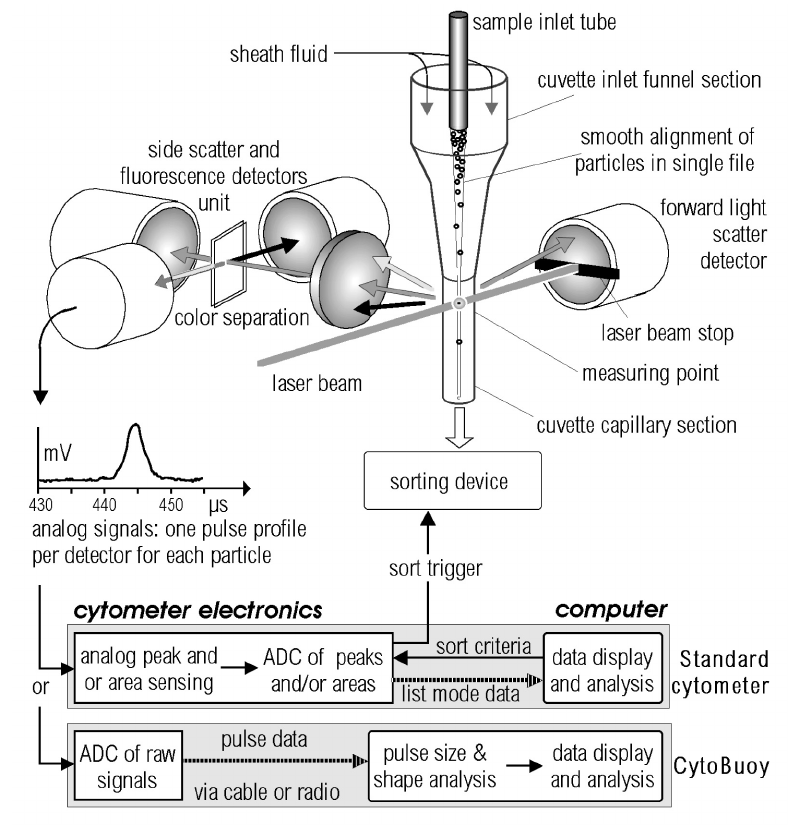
F IG . 1. – Schematic drawing of the flow cytometer operating principle and signal processing. The sample is injected in a sheath fluid that fun- nels it into a thread, so thin that the particles are well separated, intersecting a focussed laser beam one by one at high flow speed. Here, each particle emits a short (typically a few microseconds) flux of photons by scattering or fluorescing. Photodetectors convert those into electri- cal pulses. Small particles give similar, gaussian shaped pulses, following the distribution of light in the laser focus. From these signals (top electronics panel), either the pulse maximum or the pulse area is sensed with analog electronics, subsequently digitized and stored on com- puter disc in so-called list mode data files. In these files each detected particle is listed with its indiviual pulse values, one for each detector. The directly available listmode data per cell may also be used to control a sorting module for the real-time physical selection (flow sorting) of particles downstream of the laser focus. The shape and length of big diatoms and filaments dominate their detector pulses, impairing ana- log electronic processing. This requires direct digitization of the detector output (lower panel) to obtain correct pulse area (integral) values and to allow any other type of pulse analysis in principle, as applied in the CytoBuoy instrument (Dubelaar et al., 1999, Dubelaar and Gerritzen, this